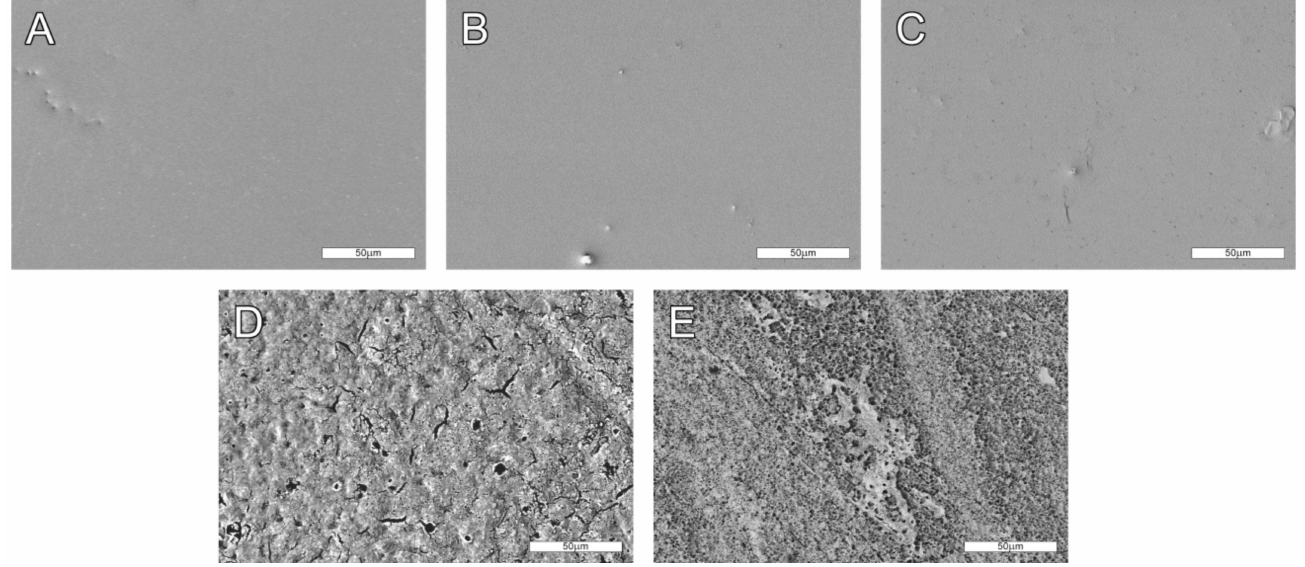
Figure 1. SEM images of analyzed samples. ( A ) Unmodified PLLA, ( B , C ) PLLA_UV_1d and PLLA_UV_7d, respectively, ( D , E ) PLLA_UV_SBF_1d and PLLA_UV_SBF_7d respectively. 500 × magnification. Comment: The surface of unmodified PLLA ( A ) is smooth and does not change much after laser exposure after a day ( B ) and a week ( C ) of air incubation. However, after irradiation and incubation in SBF for one day ( D ) and one week ( E ), the surface is more markedly rough due to deposition of the apatite ceramic on it and hydrolytic degradation of the